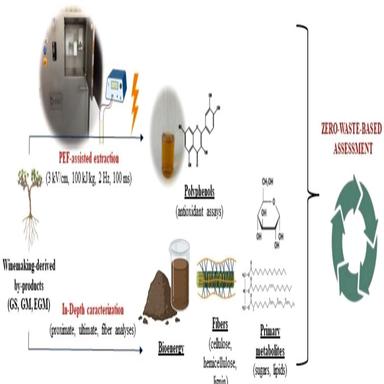
General methodology applied in this work. Abbreviations: GS: grape stalks; GM: grape marc; EGM: exhausted grape marc; PEF: pulsed electric fields. Created with BioRender.com.